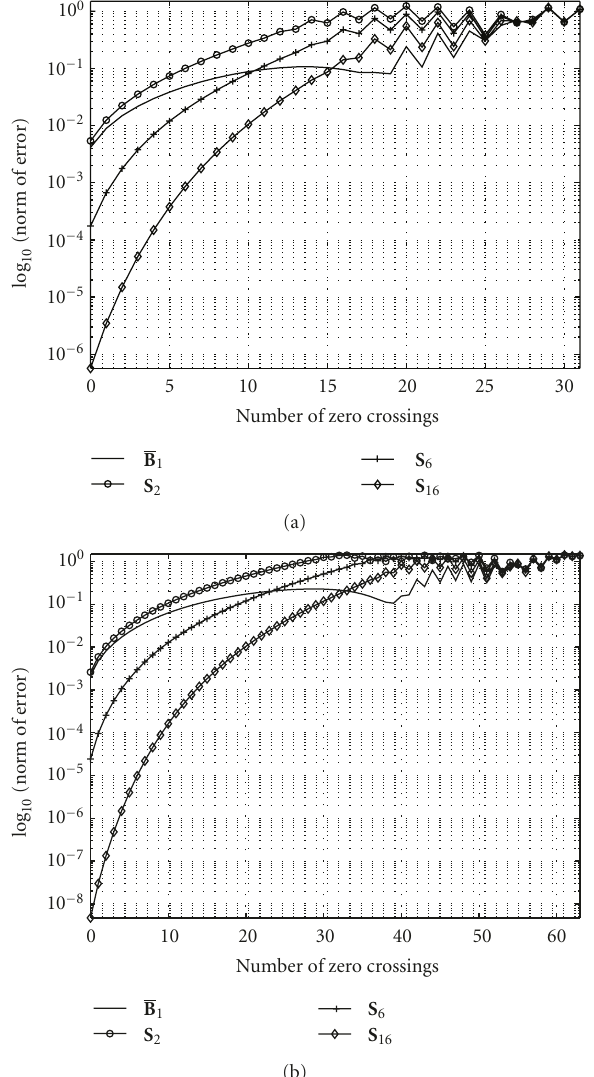
Figure 3: Error norms between the discrete Hermite-Gaussian like eigenvectors and the samples of the Hermite-Gaussian functions of B 1 method when k = 4 . 3 are compared with various other methods for (a) N = 32 and (b) N = 64.